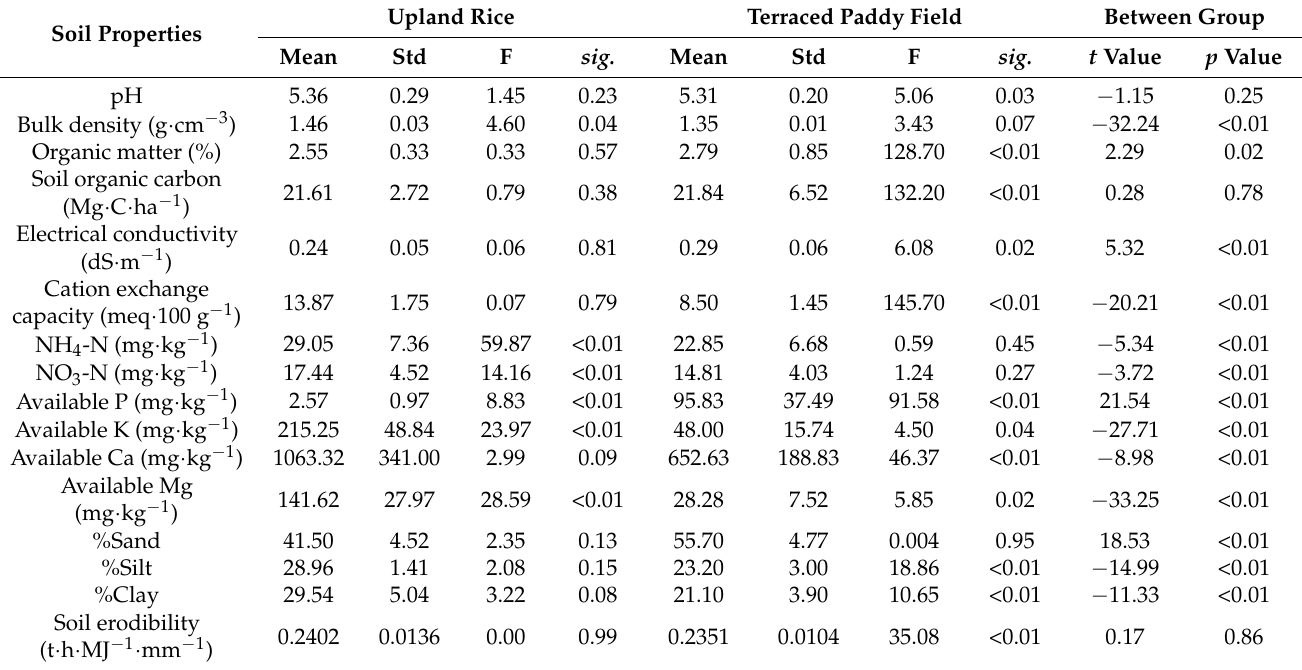
Table 1. Independent t -test comparing soil properties between upland rice ( n = 75) and terraced paddy field samples ( n =